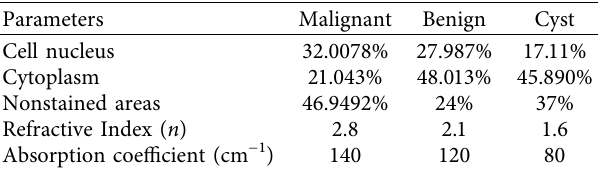
Table 2: Analysis report on H-E stained images. Parameters